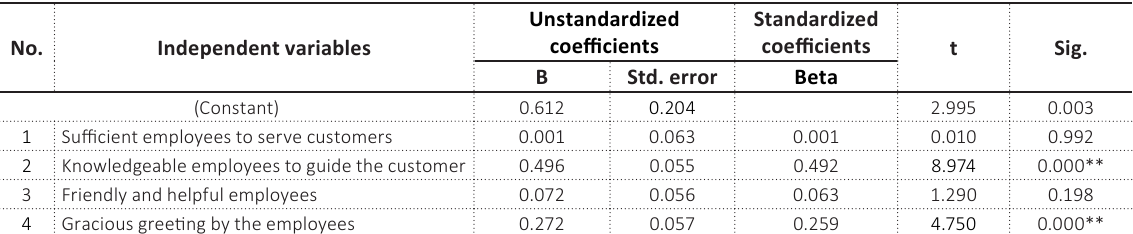
Table 17. Regression analysis of the impact of store employees’ interaction on customers’ impulse buying behavior